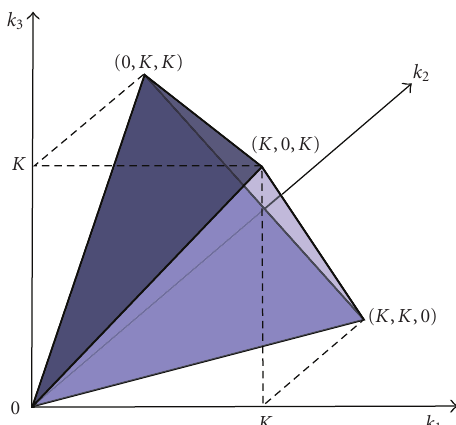
Figure 2: Tetrahedral domain for allowed wavenumber con- figurations k 1 , k 2 , k 3 contributing to the primordial bispectrum B ( k 1 , k 2 , k 3 ). A regular tetrahedron is shown satisfying k 1 + k 2 + k 3 ≤ 2 k max ≡ 2 K